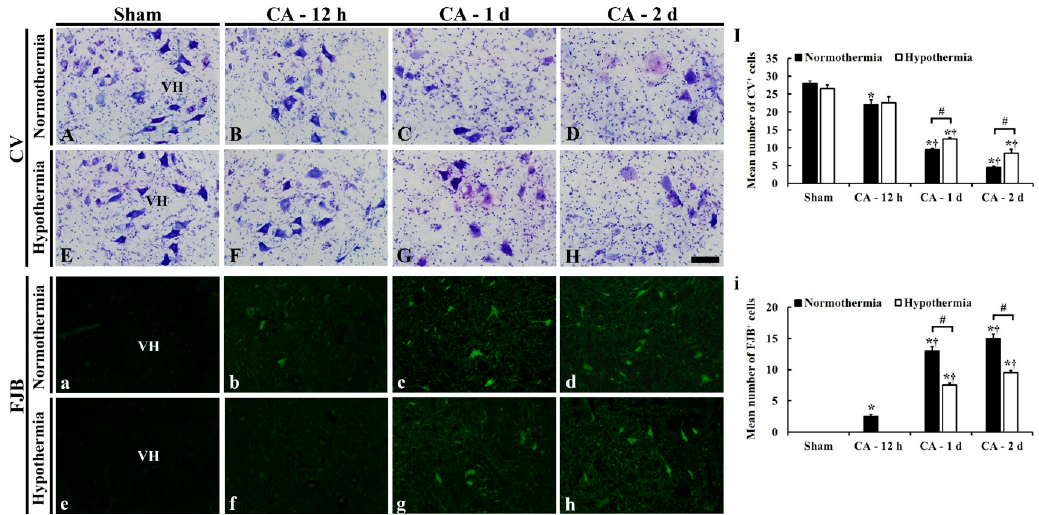
Figure 3. CV staining ( A – H ) and FJB fluorescence staining ( a – h ) in the lumbar ventral horn of sham / normothermia ( A , a ), ACA / normothermia ( B – D , b – d ), sham / hypothermia ( E , e ), and ACA / hypothermia ( F – H , f – h ) group. In the sham / normothermia and sham / hypothermia groups, many CV-positive and no FJB-positive motor neurons were found. In the ACA / normothermia group, CV-positive cells are gradually damaged and reduced in number from 12 h until 2 days after ACA. A few FJB-positive neurons are shown at 12 h after ACA; thereafter, many FJB-positive neurons are detected until 2 days after ACA. In the ACA / hypothermia group, CV-positive cells are much less damaged at 12 h, 1 day, and 2 days after ACA than those in the ACA / normothermia groups. FJB-positive cells are not shown at 12 h after ACA, and their number at 1 and 2 days was lower than that in the ACA / normothermia group. VH, ventral horn. Scale bar = 100 µ m. ( I,i ) Mean number of ( I ) CV- and ( i ) FJB-positive motor neurons in the ventral horn. The bars indicate the means ± SEM ( n = 5 and 7 for the sham and ACA groups; * p < 0.05 vs. the sham group; # p < 0.05 vs. the ACA / normothermia group; † p < 0.05 vs. the previous time-point